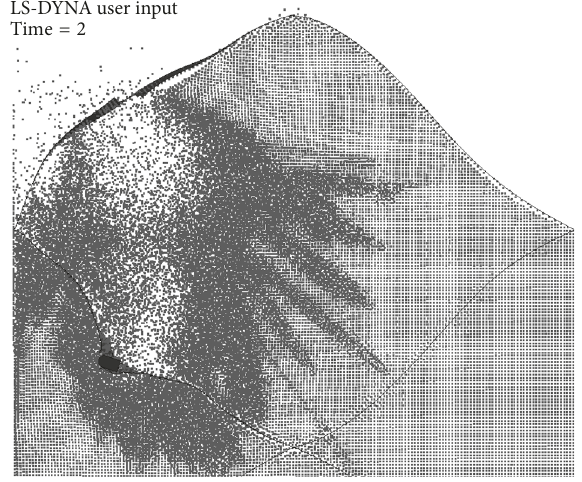
Figure 11: Penetration from off-axis by MCPB.